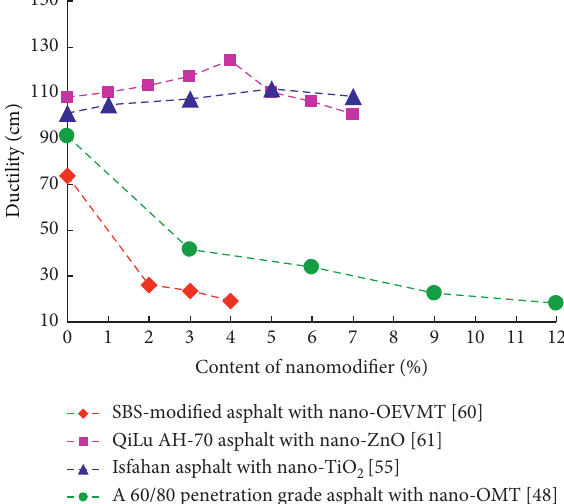
Figure 11: Rutting factor and nanomodifier content.